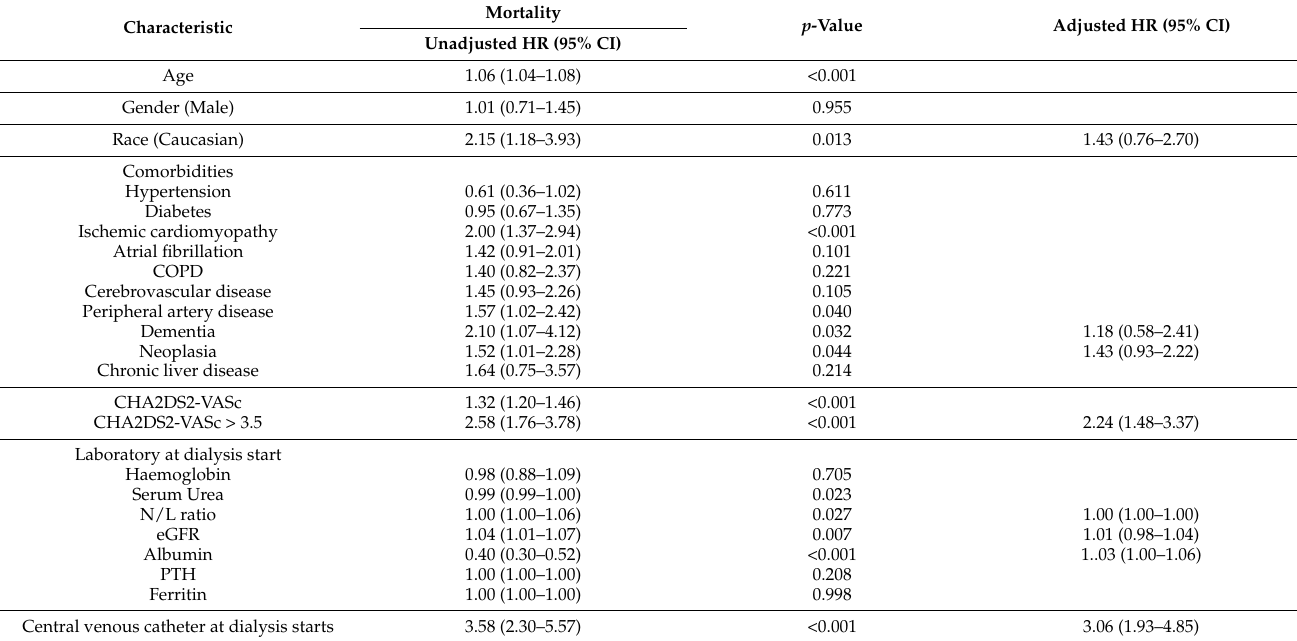
Table 3. Factors predictive of early mortality.